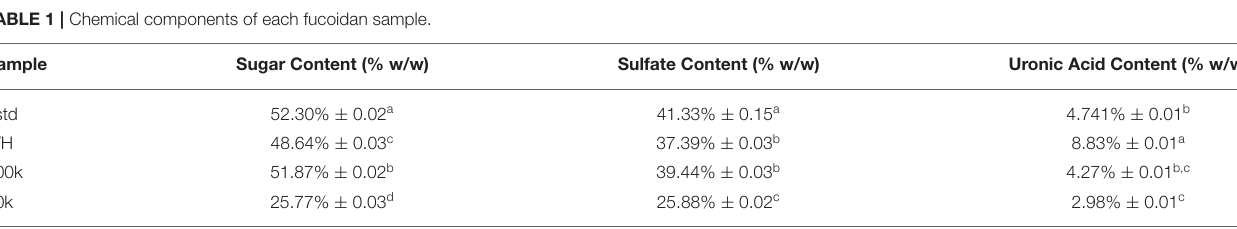
TABLE 1 | Chemical components of each fucoidan